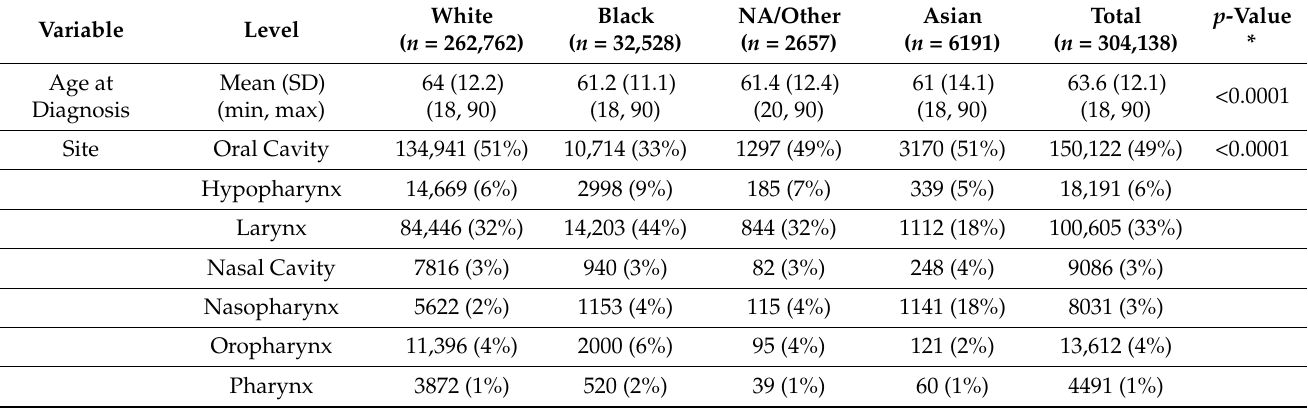
Table 1. Demographic and Clinical Characteristics by Racial/Ethnic